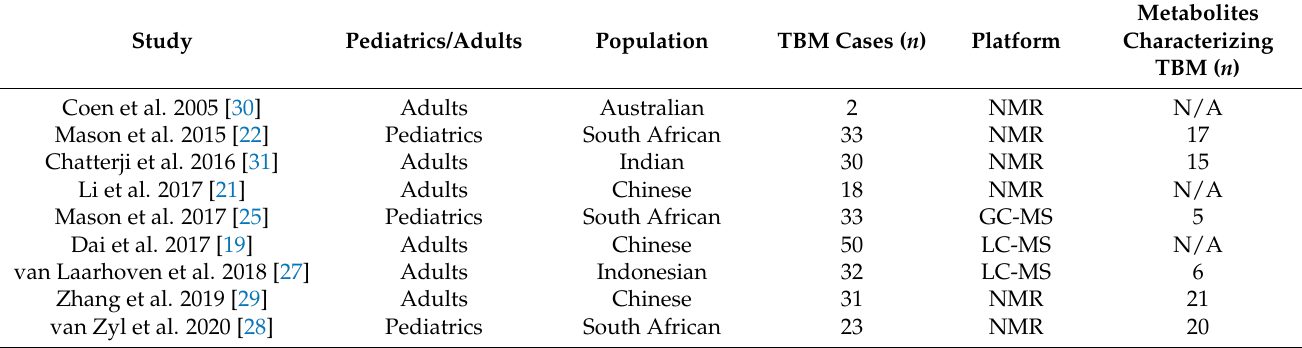
Table 2. List of CSF metabolomics studies from the literature focused on tuberculous meningitis in human participants.